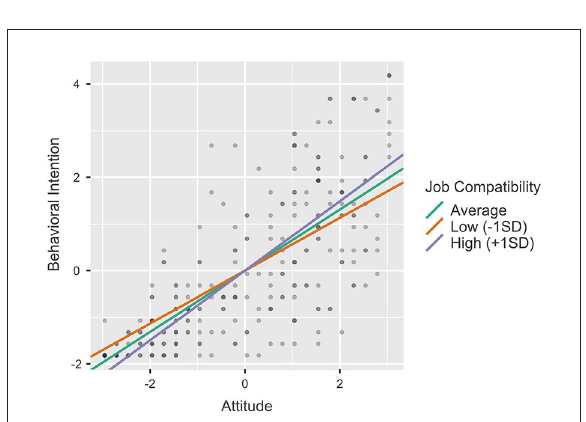
FIGURE4 Single slope plot—Job compatibility.